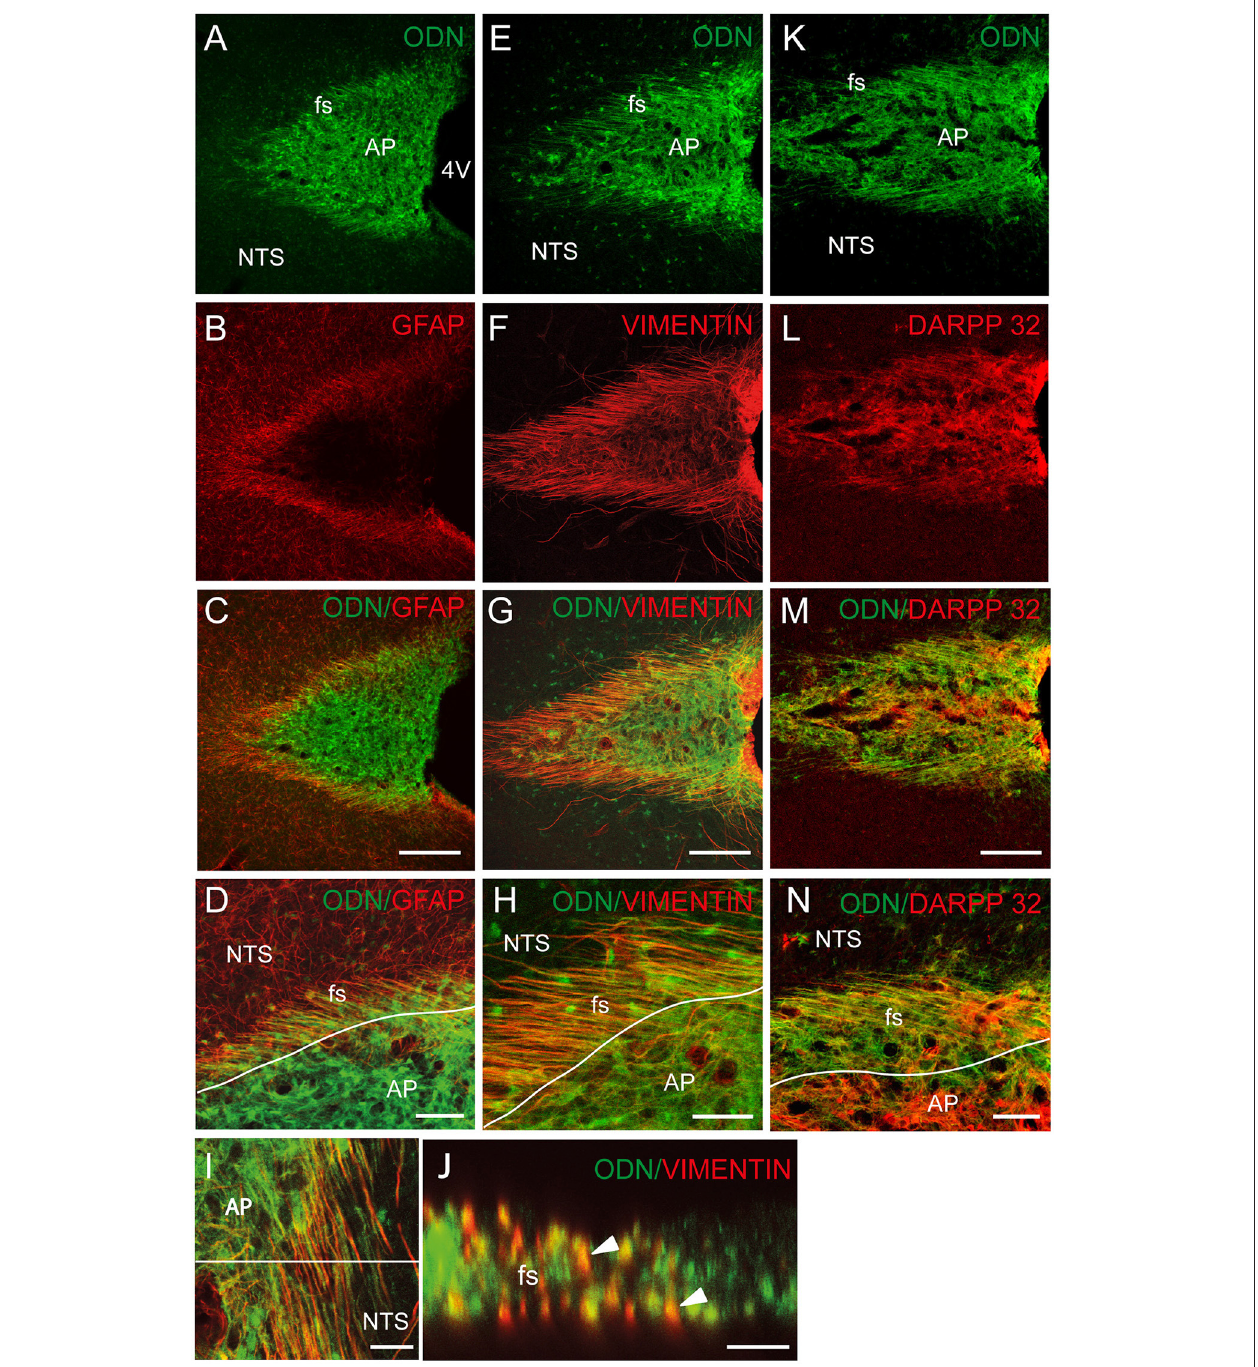
FIGURE 2 | Tanycytes-likes cells of the brainstem are ODN positive. (A–C) ODN partly co-localized with GFAP immunostaining within the dorsal vagal complex (DVC). The presence of ODN/GFAP-positive processes was visualized at the nucleus tractus solitarius/area postrema (NTS/AP) border (A–C) . High magnifications illustrated the presence of ODN/GFAP double labeled radial processes (D) . (E–H) ODN partly co-localized with vimentin within the AP, at the AP/NTS interface i.e., funiculus separens (fs) and on the wall of the 4th ventricle (4V). (I) ODN/vimentin-positive processes originating from cells lining the 4th ventricle and radiating rostro-caudally were observed on horizontal sections of the DVC. A partial co-localization was also observed within the AP. (J) XZ orthogonal projection of images acquired on horizontal sections confirmed the presence of ODN/vimentin-positive processes surrounding the AP (arrowheads). (K–M) ODN/DARPP 32 co-localization within the AP and NTS/AP border. (N) High magnification illustrating ODN/DARPP 32 co-localization in long, radiating processes and cells located within the AP. Lines in D, H and N symbolize the AP boundary. Scale bars: 100 µ m in (A–C) , (E–G) , and (K–M) ; 40 µ m in ( D,H,N ; 5 µ m in I and J .